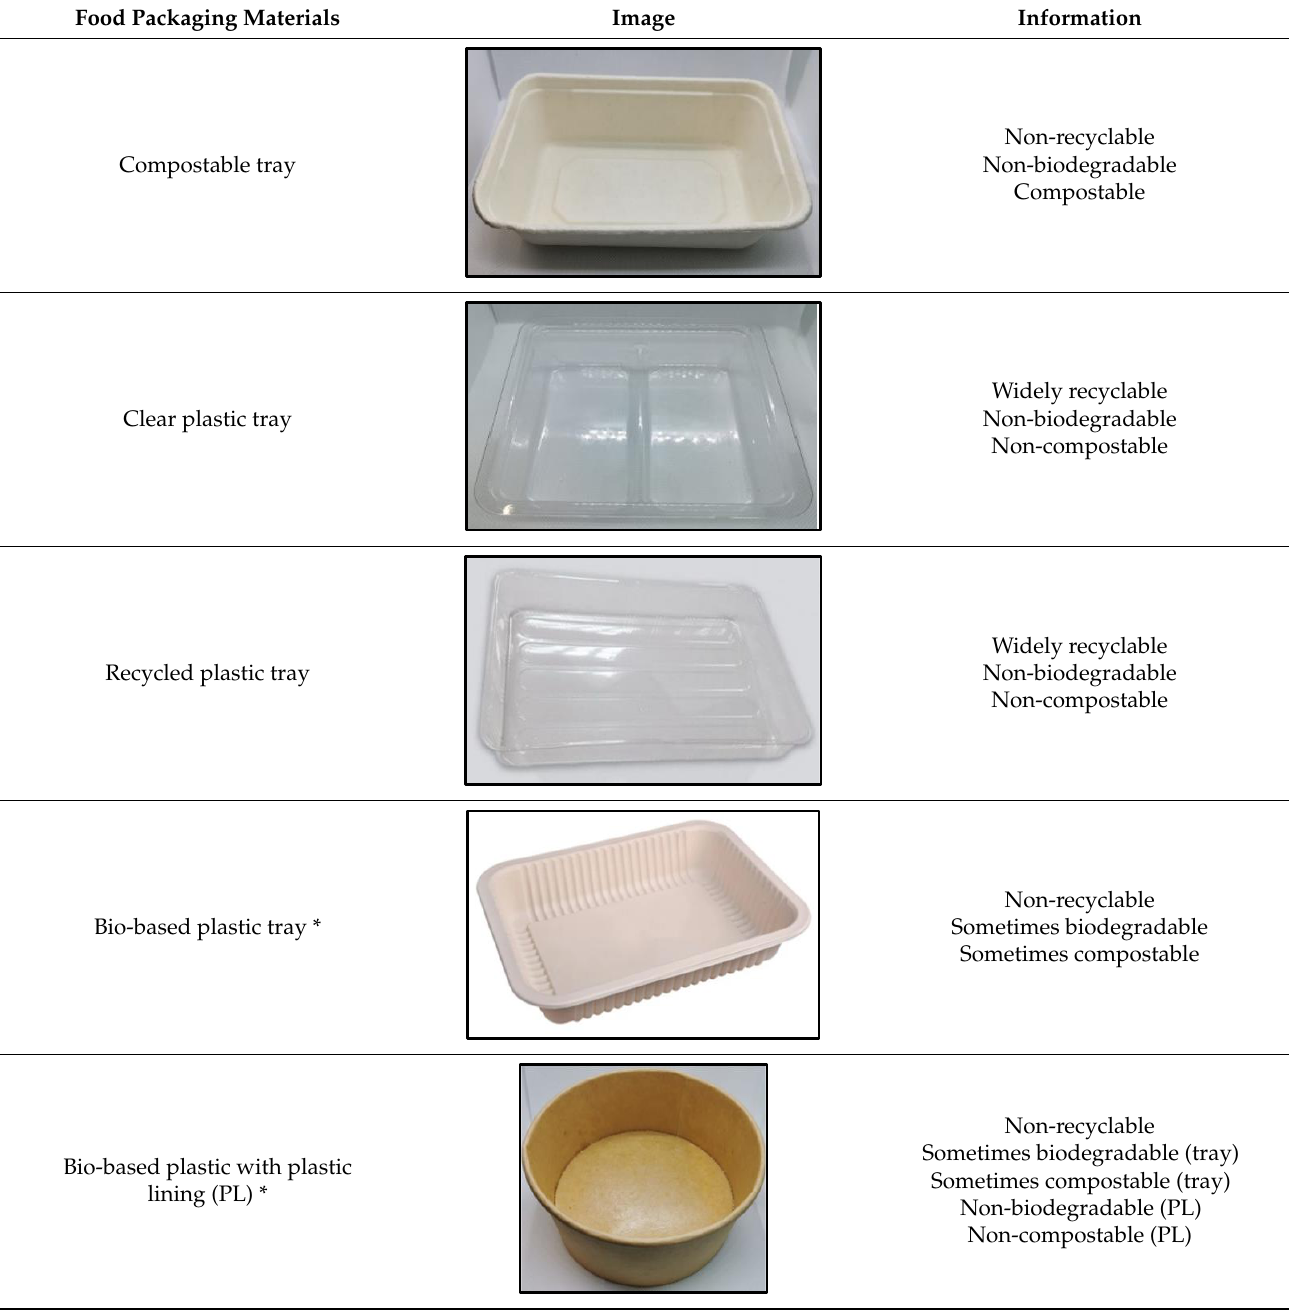
Figure 1. Example of food package with recycling information. This question was asked to determine whether consumers were likely to follow recycling instructions if added to food packaging using a five-point category scale (1: would definitely not follow the instructions to 5: would definitely follow the instructions). Table 1. Summary of food packaging materials included in the ranking task and preference test.